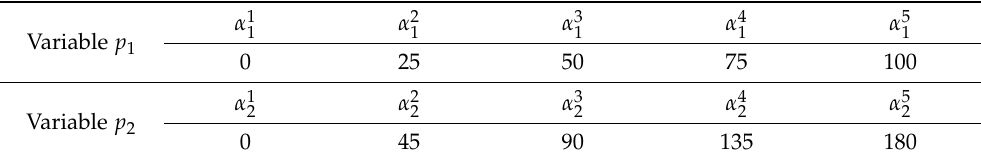
Figure 10. Fuzzy sets of consequent variables.